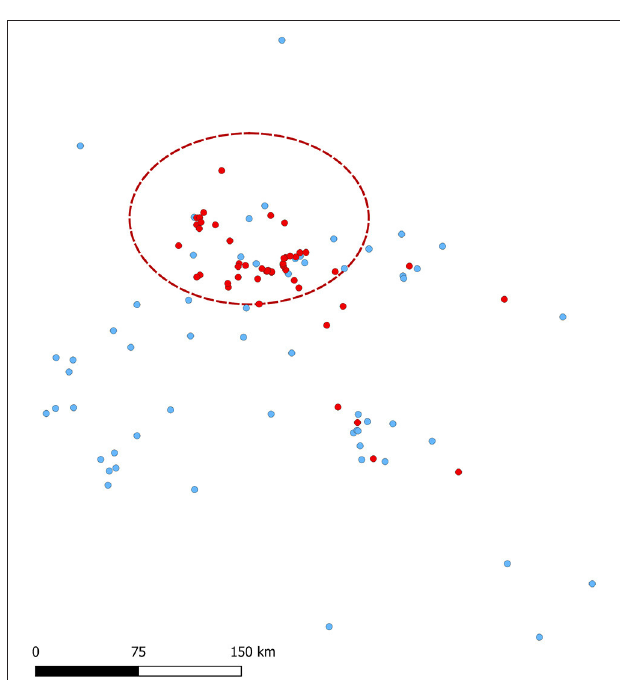
FIGURE 4 | Cases (red) and controls (blue) spatial distribution and spatial clustering of cases (red dashed